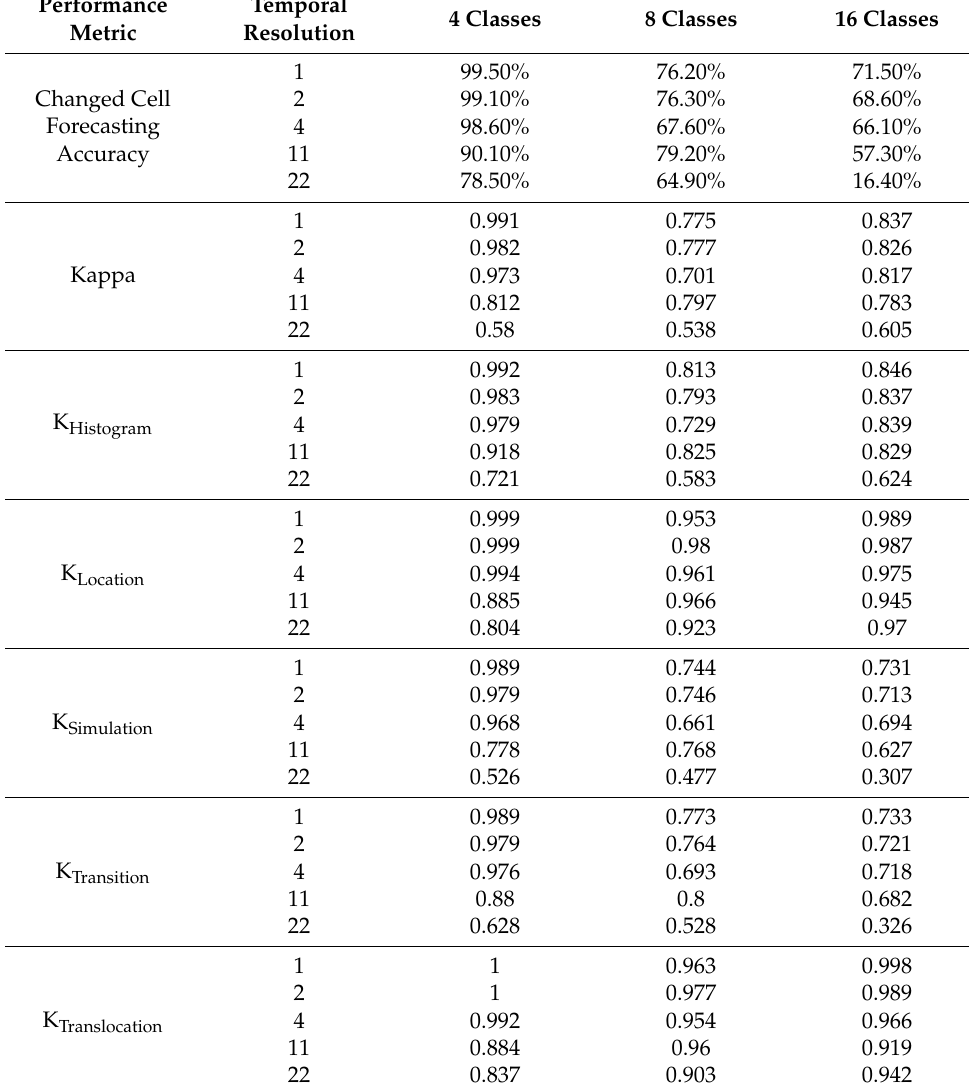
Table 7. Metrics obtained using 45-year hypothetical LC datasets featuring 4, 8, and 16